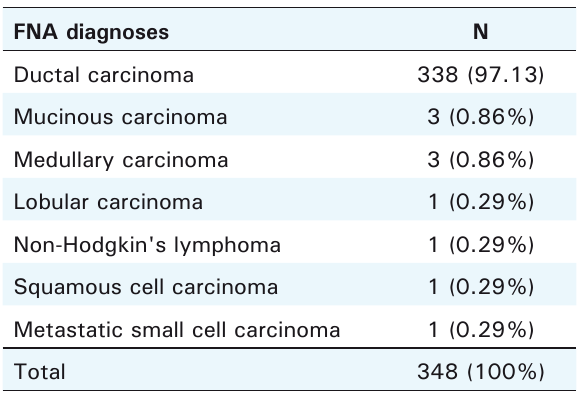
table 2. FNA diagnoses of malignant cases. FNA diagnoses N Ductal carcinoma